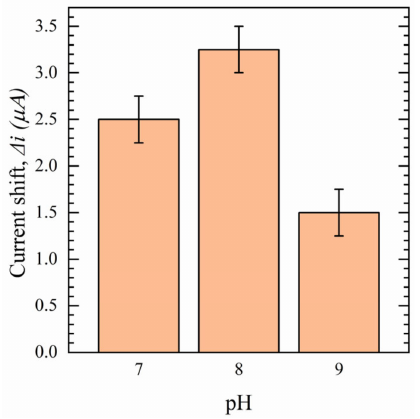
Figure 7. Effect of pH on sensor performance in 100 nM S protein in 0.1 M PBS ( n = 3).